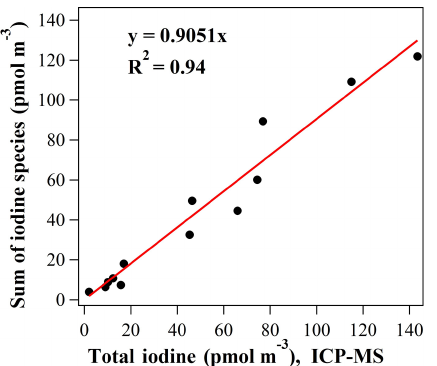
Figure 7. A comparison between the sum of all iodine species measured by our method and total iodine concentration measured by ICP-MS. Red line shows the linear regression between the two methods with a R 2 of 0.94.